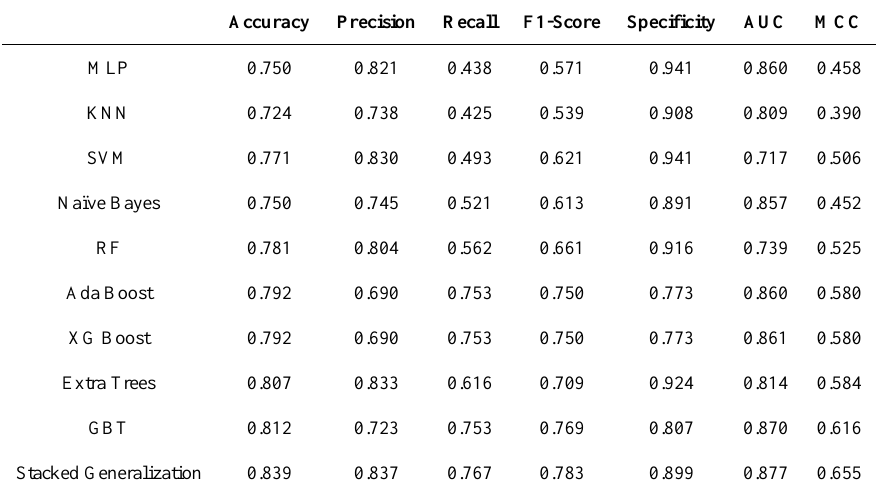
Table 6. Performance of various base learners models on Pima diabetes dataset Accuracy Precision Recall